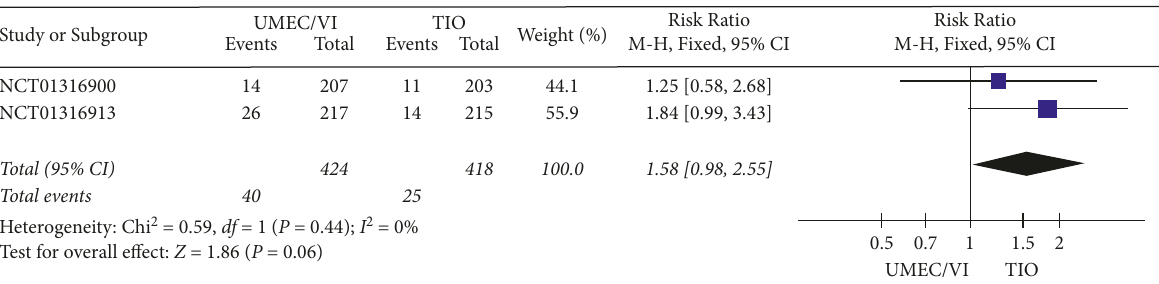
Figure 3: Forest plot of exacerbation rate for UMEC/VI vs. TIO using random-effects